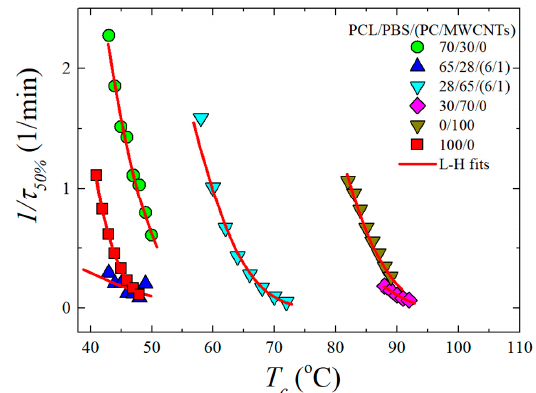
Figure 6. Half crystallization time ( 1/t 50% ) as a function of isothermal crystallization temperature ( T c ) for PCL (temperatures below 60 ° C) and PBS (temperatures above 60 ° C). The red solid lines represent fits to the LH theory.